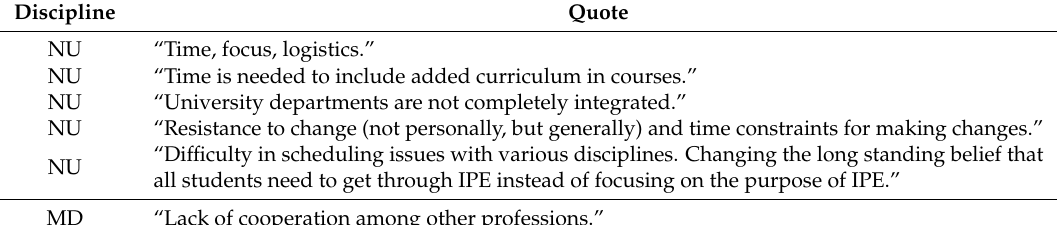
Table 4. Quotes that support negative